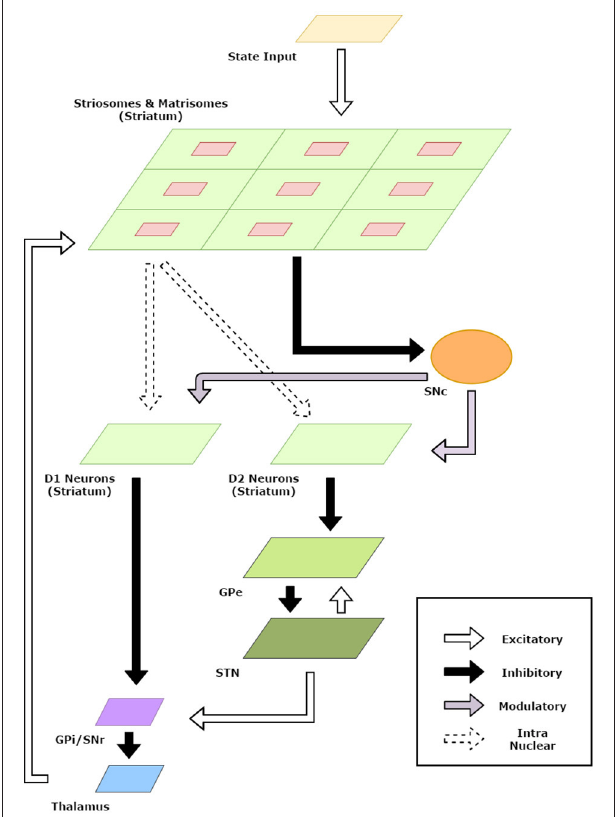
FIGURE 2 | Schematic Diagram for the basal ganglia model. The arrows indicate connections and their type. The component sizes are proportional to their dimensions. The feedback connections from the thalamus project the information about the action chosen back to the striatum.